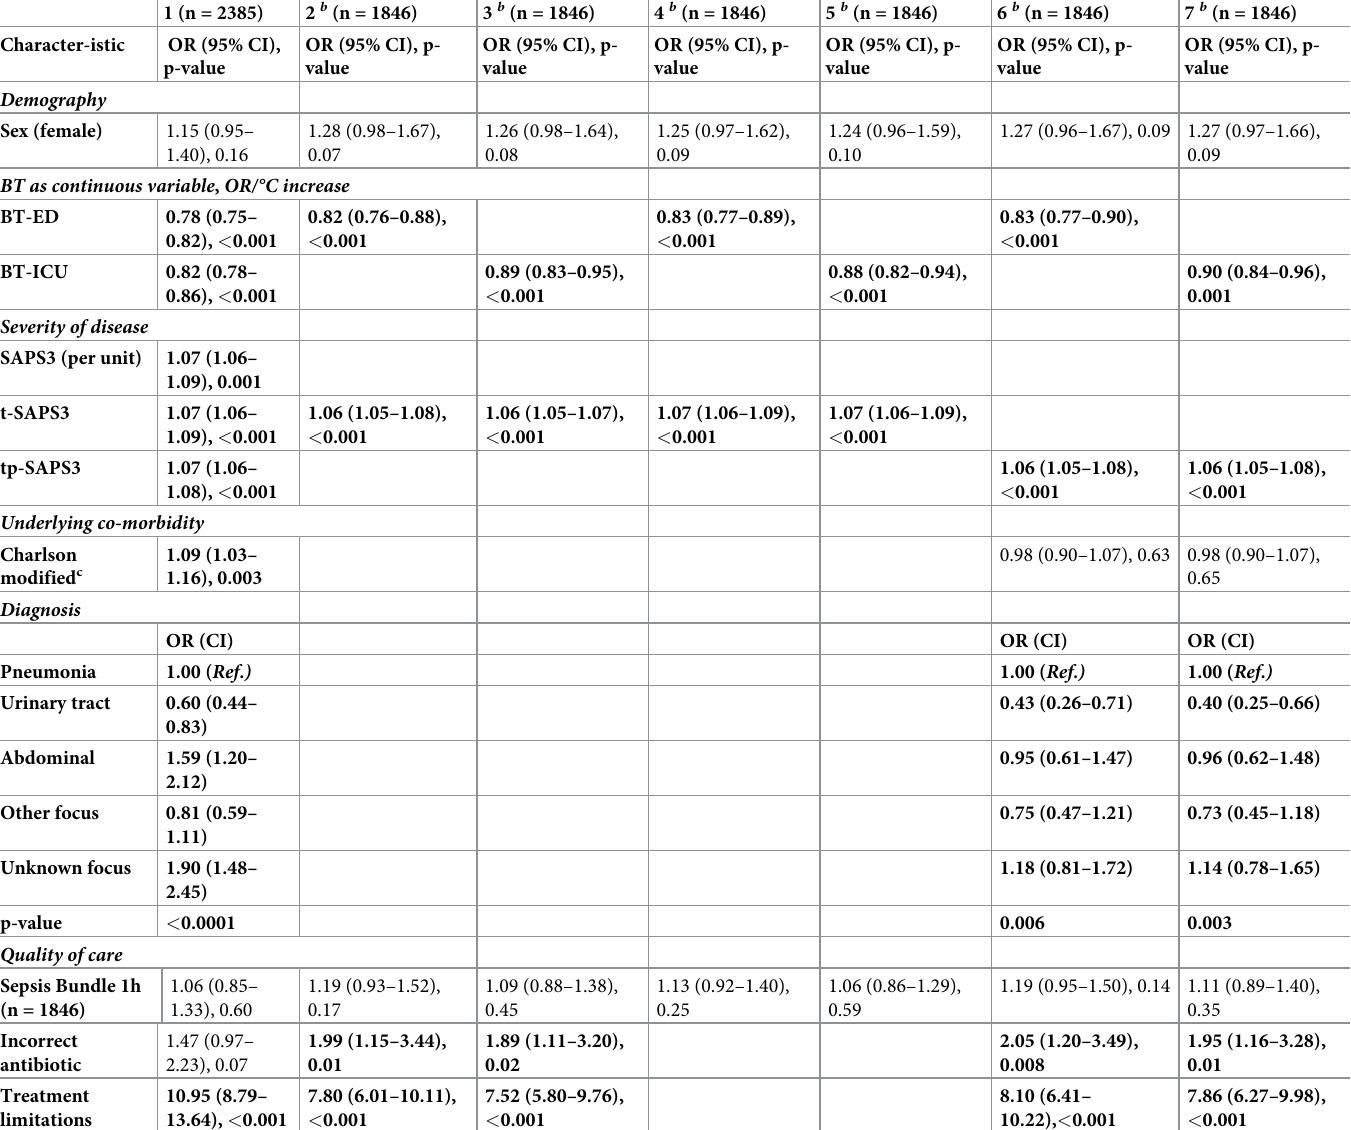
Table 3. Odds ratios for death according to admission temperature, additional models a